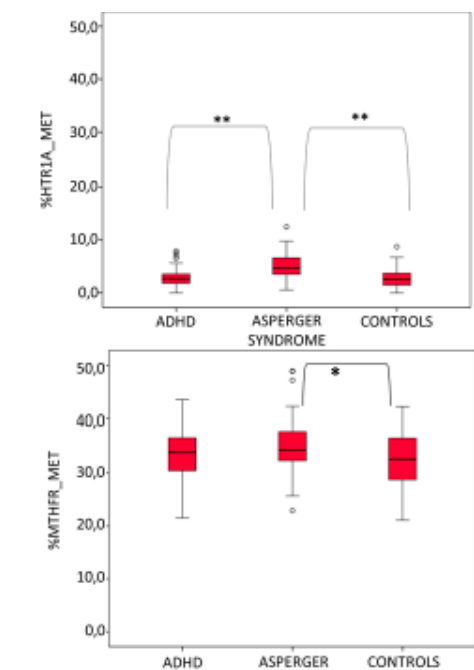
and healthy control mothers (** = difference between groups statistically significant, * = difference